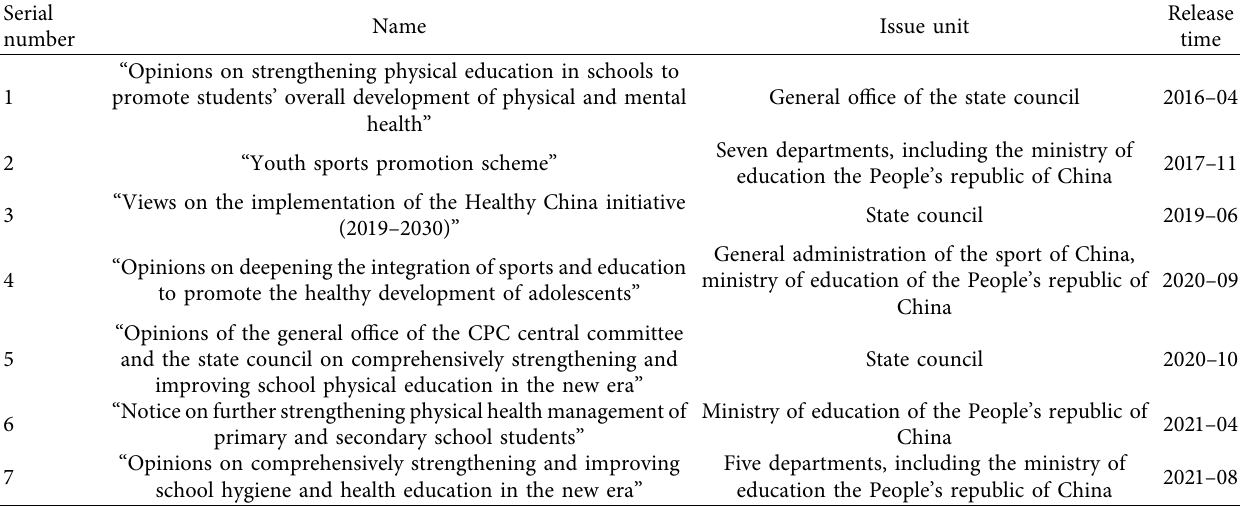
Table 1: List of relevant policies for promoting college students’ physical fitness since 2016